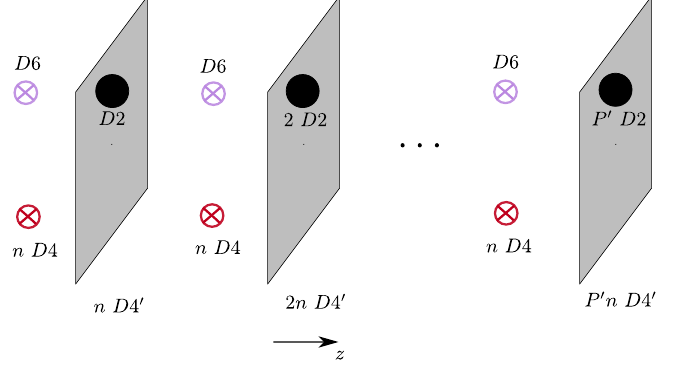
Figure 9 . Brane set-up in the z -direction, for y and ρ constants. The numbers of D4 and D6 branes at each interval are given by their respective magnetic charges. Instead, for the numbers of D2 and D4’ branes we give their electric charges (computed in (3.24) and (3.25)) as these are the ones that play a role in their interpretation as baryon